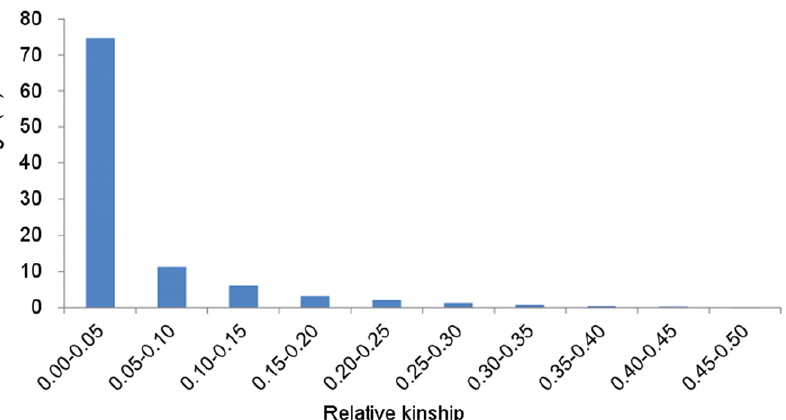
Figure 2. Distribution of pair-wise kinship coefficients among 266 bread wheat accessions based on 70 whole genome SSR markers.